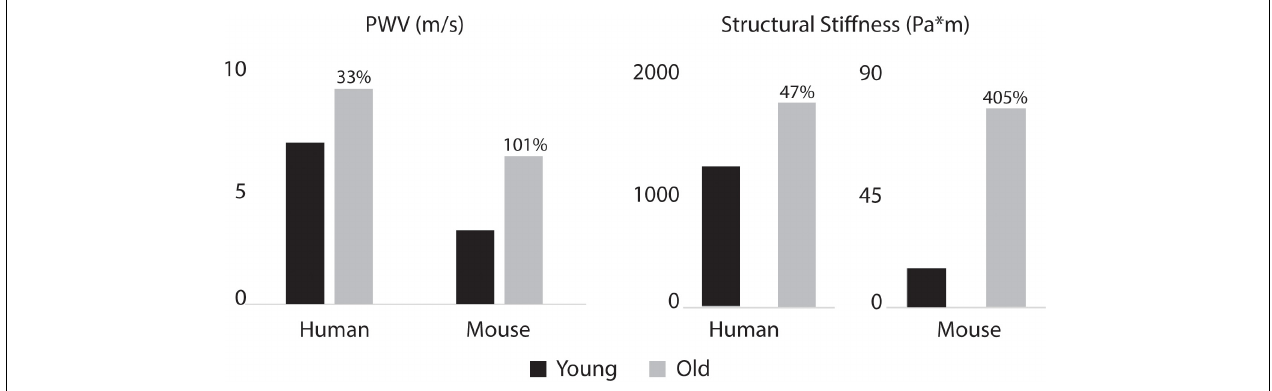
FIGURE 10 | Aorto-iliac PWV (left) and spatially weighted averages of structural aortic stiffness (right) for the humans and mice. Percent difference from young to old are indicated for both species. Baseline values for the young subjects were 6.9 m/s for human and 3.2 m/s for mouse PWV and 1195.7 and 15.3 for human and mouse structural